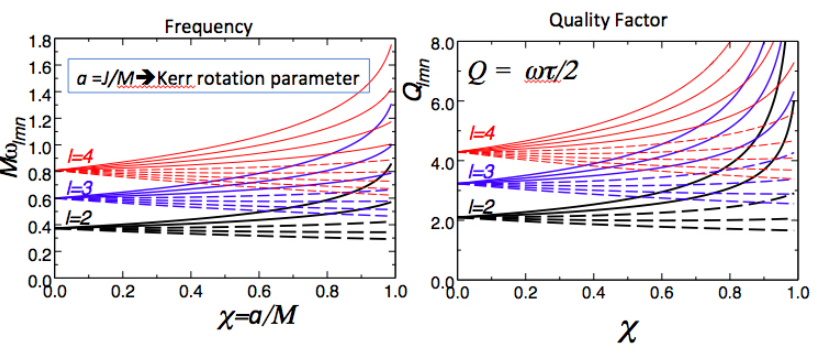
Figure 2. Frequencies and quality factors for the fundamental modes with l = 2 , 3 , 4 and different values of m. Solid lines refer to m = l,..,l (from top to bottom), the dotted line to m = 0, and dashed lines refer to m = 1, .., l (from top to bottom). Quality factors for the higher overtones are lower than the ones we display